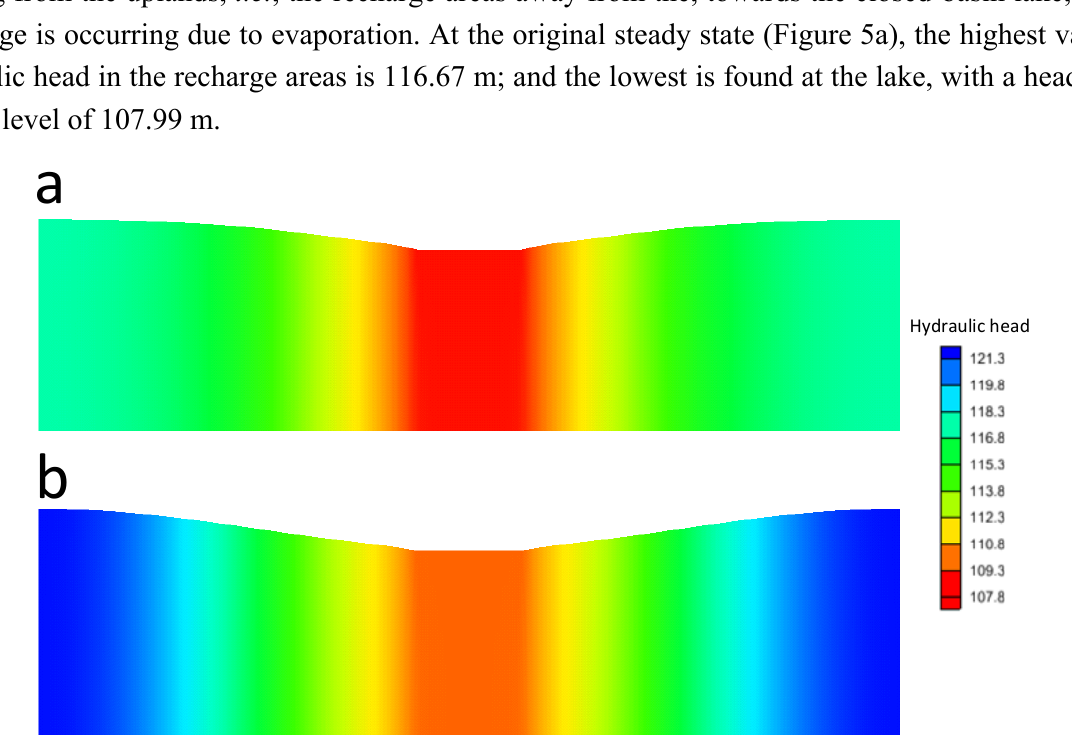
Figure 5. Cross-section representations of the steady-state hydraulic-head field and lake-water level or stage under ( a ) pre-perturbed and ( b ) post-perturbed climatic conditions. When the recharge rate is increased to 200 mm/year (Figure 5b), the hydraulic head values